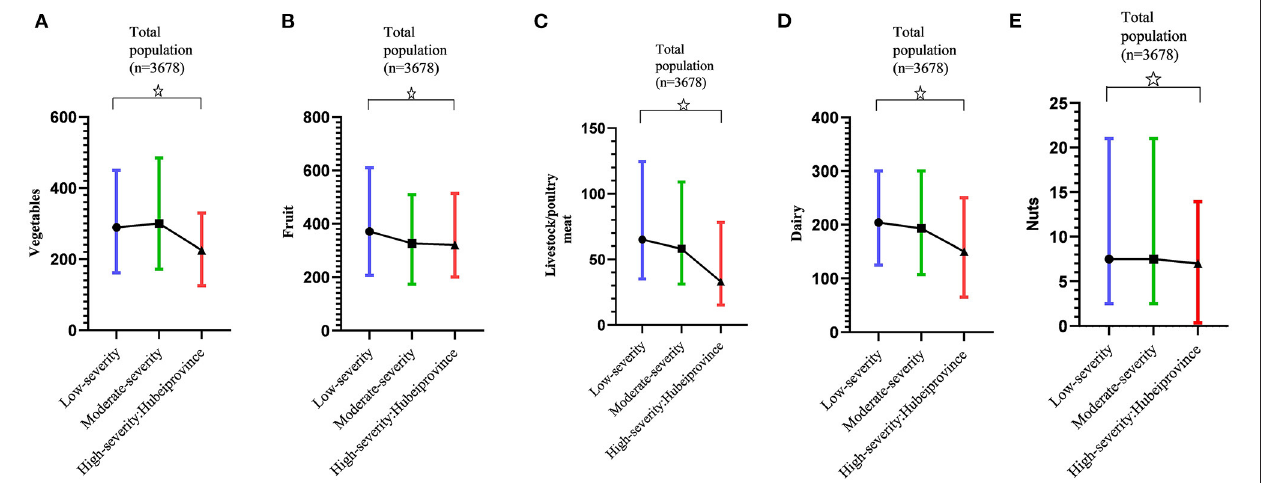
FIGURE 3 | Variation of daily food intake according to COVID-19 pandemic severity. (A) Variation of daily intake of vegetables according to COVID-19 pandemic severity. (B) Variation of daily intake of fruit according to COVID-19 pandemic severity. (C) Variation of daily intake of livestock/poultry meat according to COVID-19 pandemic severity. (D) Variation of daily intake of dairy according to COVID-19 pandemic severity. (E) Variation of daily intake of nuts according to COVID-19 pandemic severity. Daily intake of vegetables, fruit, livestock/poultry meat, dairy and nuts were presented as median (interquartile range, IQR). ☆ Linear trends were statistically significant ( p < 0.05).